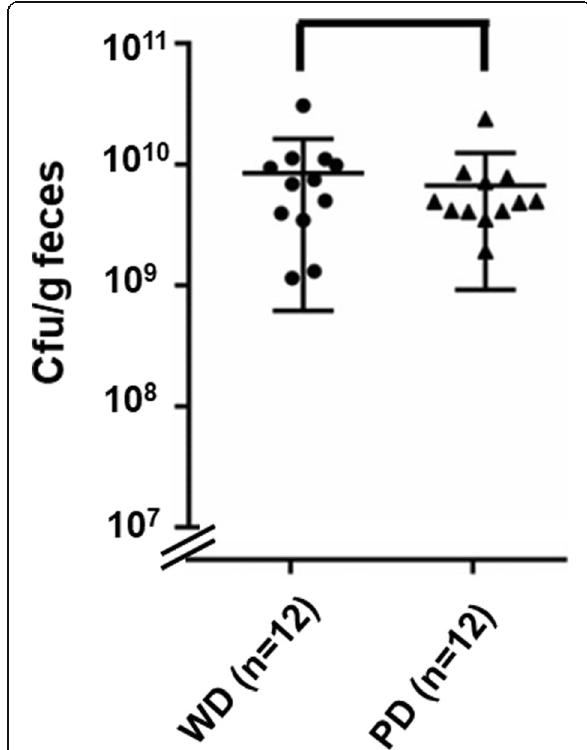
Fig. 4 Diet-dependent load of S. Typhimurium 24 h post infection. Twelve mice per group were infected with 5 × 10 7 cells of strain ST4/74 Δ invA . No significant difference between the averaged CFU were